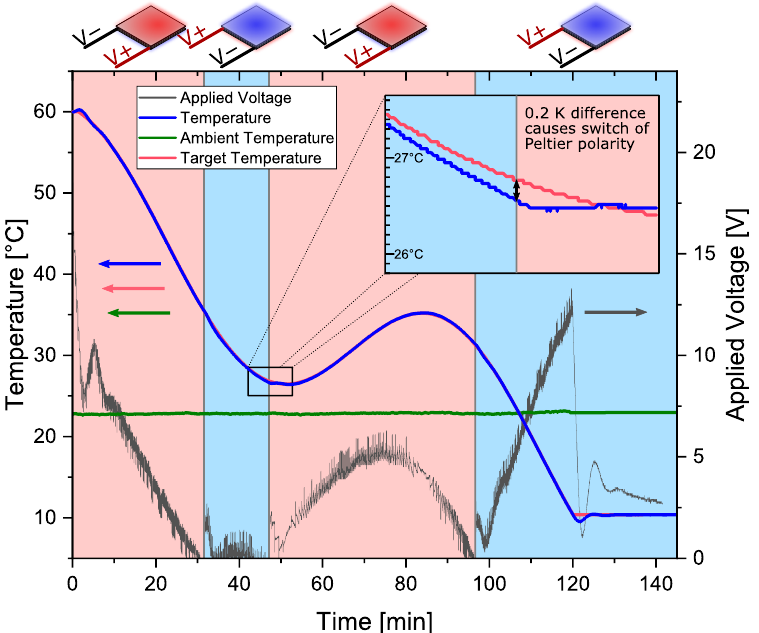
Figure 4. Temperature control strategy demonstrated with an oscillating temperature profile and 100g sucrose solution (saturated at 60°C). Seeded with 0.025g · g − 1 seeds of 63–90µm sieve size fraction. ECM The red background indicates that the Peltier elements are in heating. The blue background indicates cooling. The blue line is the actual temperature, the red is the target temperature, respectively. Grey shows the absolute value of the applied voltage to the Peltier